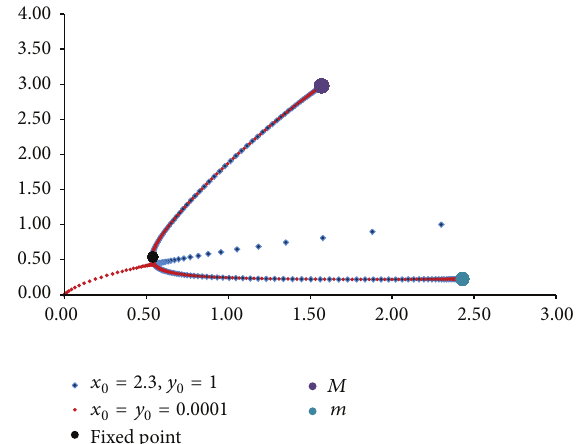
Figure 1: Orbits illustrating period two oscillations and the saddle